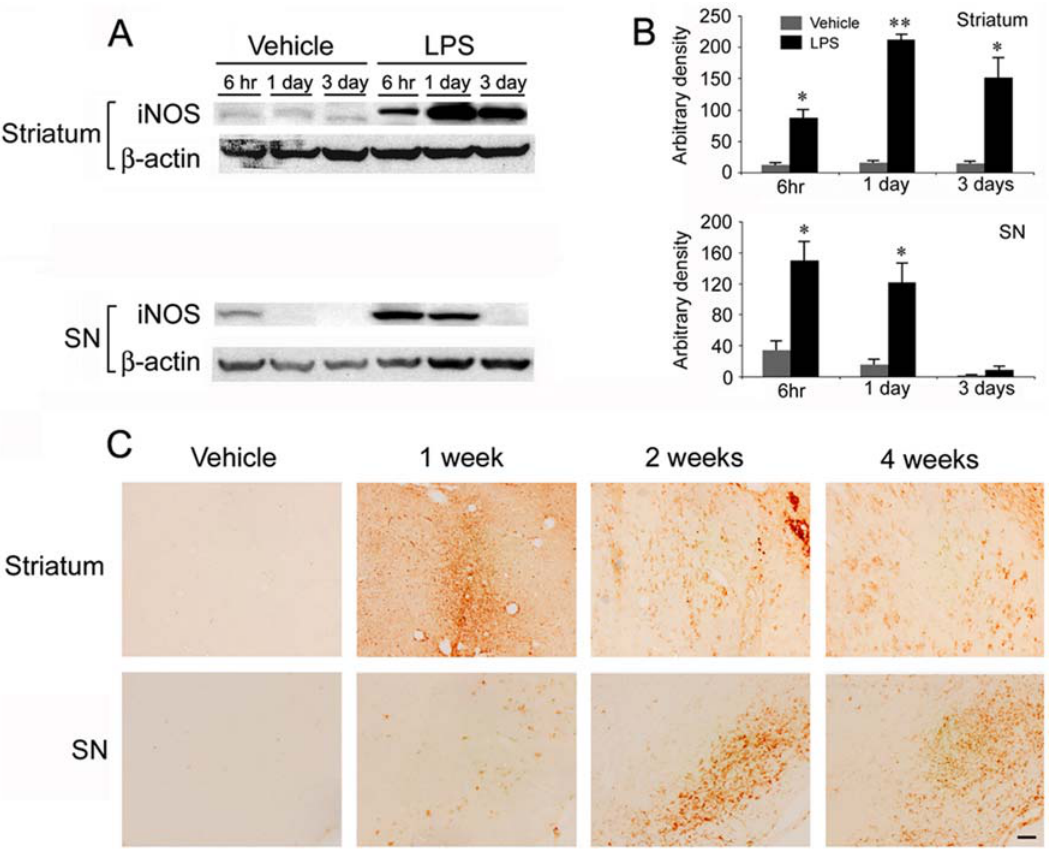
Figure 5. Microglial activation and elevation of iNOS expression in both the substantia nigra and striatum following intrastriatal LPS injection. The increased iNOS expression occurs at 6 hr post LPS injection, which is sustained for three days in the striatum, and one day in the substantia nigra (n=3/group, * p , 0.05, ** p , 0.01 vs. control) (A,B). The OX-6 immunoreactivity in the LPS-injected striatum is markedly increased one week after LPS injections compared to control or the naı¨ve side, and immunoreactivity of OX-6 gradually decreased over time. However, the immunoreactivity is still positive four weeks after LPS (C, top). OX-6-positive microglia appear in the substantia nigra one week after intrastriatal LPS injection, and the immunoreactivity peaks at two weeks and then decreases to some extent at four weeks (C, bottom). Scale bar: 50 m m.